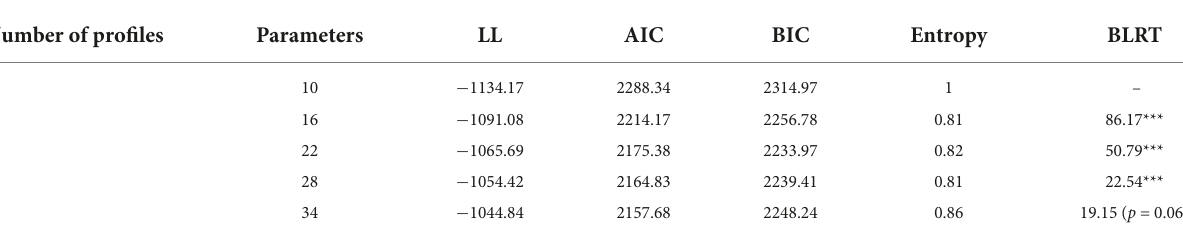
TABLE 1 Fit indices for latent profiles analyses ( N = 106).